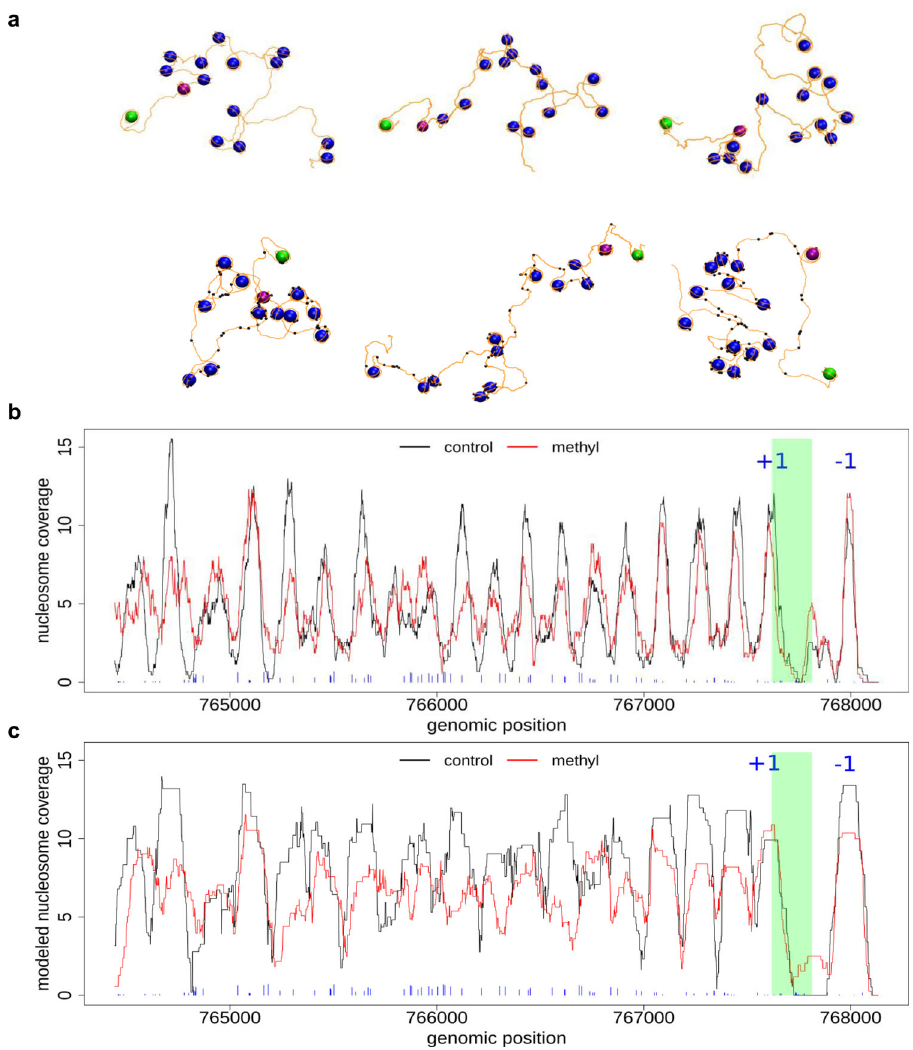
Fig. 3 Modeled nucleosome fi bers from MNase-seq data. a Modeled nucleosome fi ber for (top panel) control and (lower panel) methylated cells. DNA base pairs are depicted as orange lines and nucleosomes as blue spheres ( + 1 and − 1 nucleosomes are depicted in purple and green, respectively). Methylated regions (signal above 10% coverage) are highlighted as black balls. Experimental ( b ) and modeled ( c ) nucleosome position coverage for DUG2 gene (chromosome II). The TSS is highlighted in green and nucleosomes − 1 and + 1 are indicated. The blue sticks in the bottom correspond to methylated regions with their height proportional to methylation